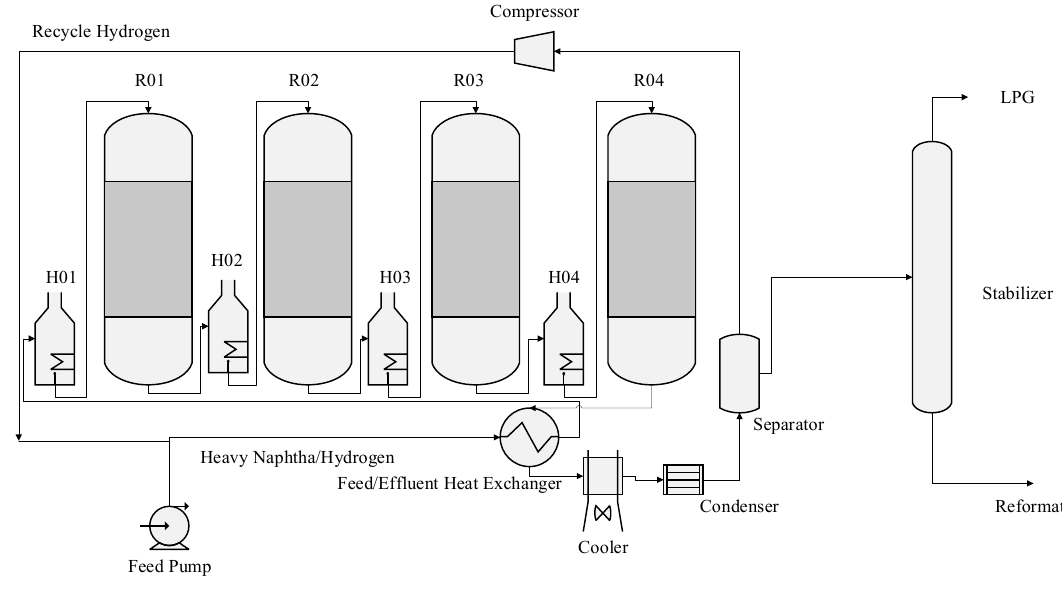
Figure 2. Catalytic Reforming processes. Table 1. Effect of variables on product distribution, coke and Research octane number (RON).